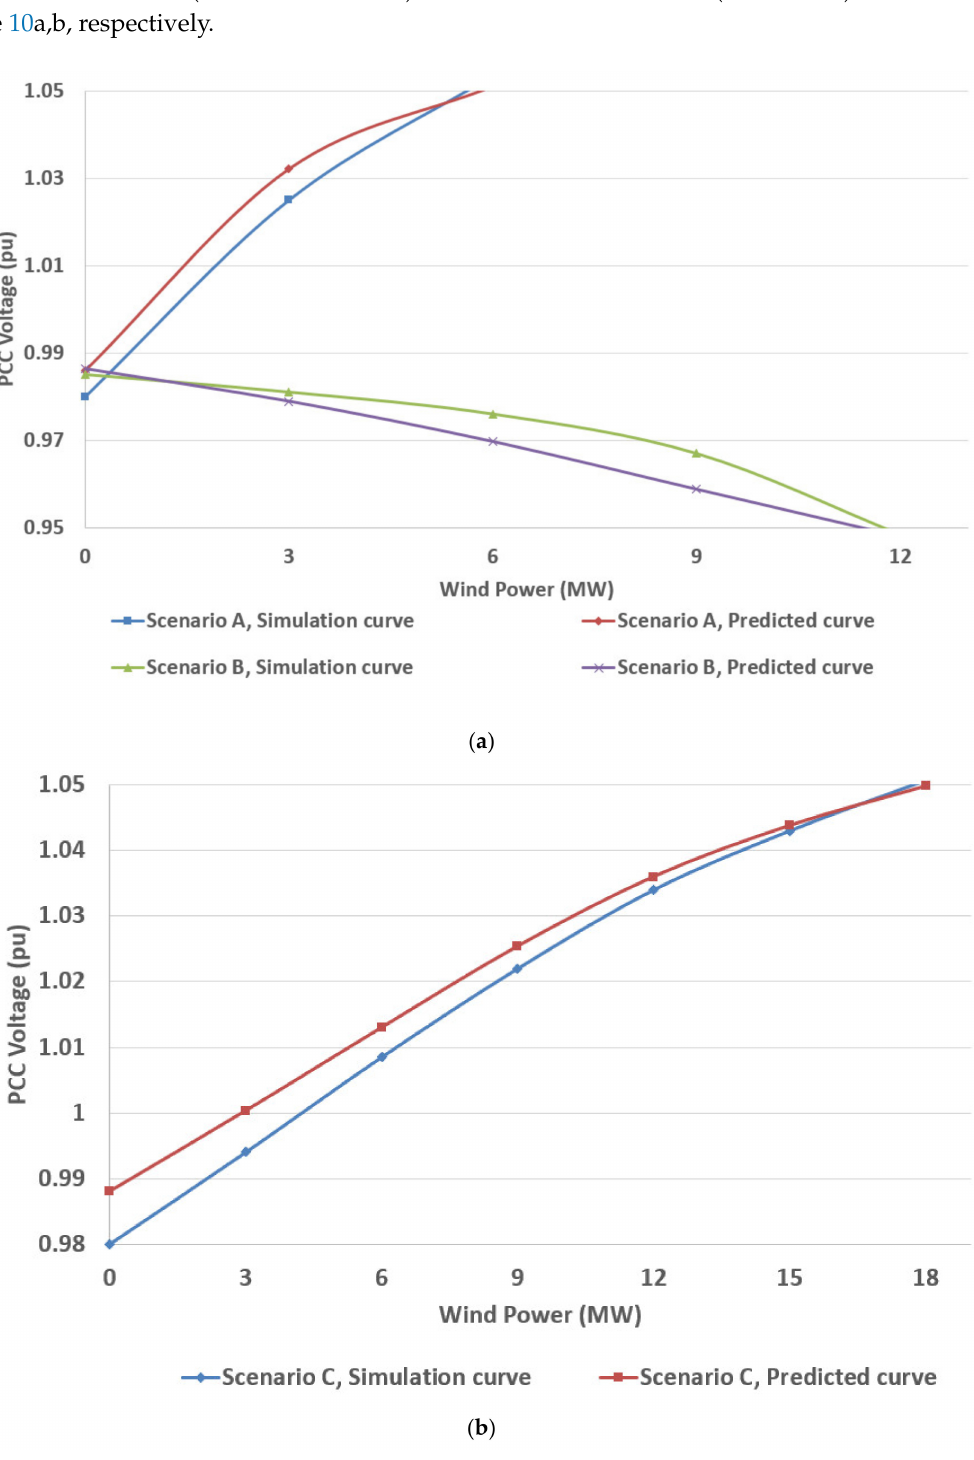
Figure 10. P wind versus V PCC curves for validation scenarios considered for the 30-bus test system. ( a ) Scenarios A and B; ( b ) Scenario